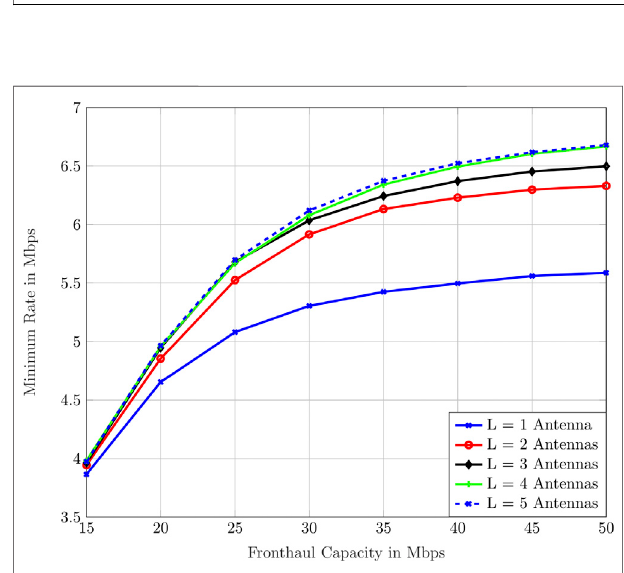
FIGURE 5 | MMF rate as a function of the fronthaul capacity for the statistical CSIT case. We consider different numbers of transmit antennas at the